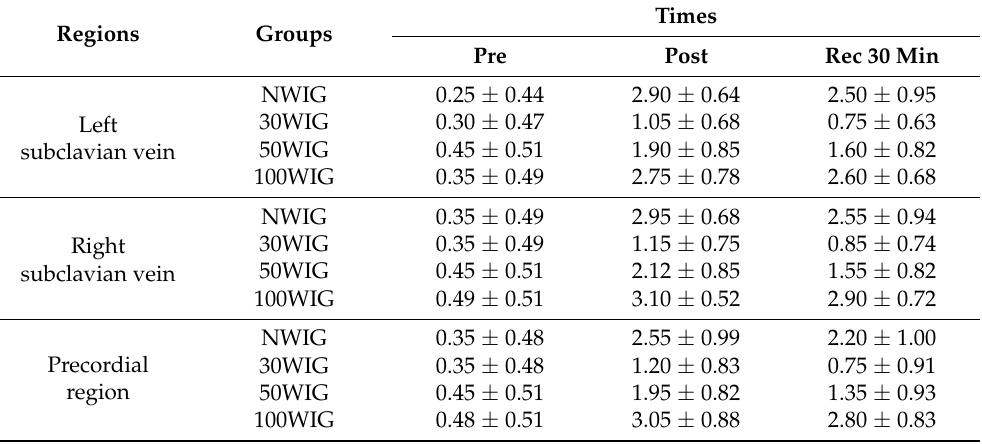
Table 3. Frequency * in the left and right subclavian veins and precordial region. Regions